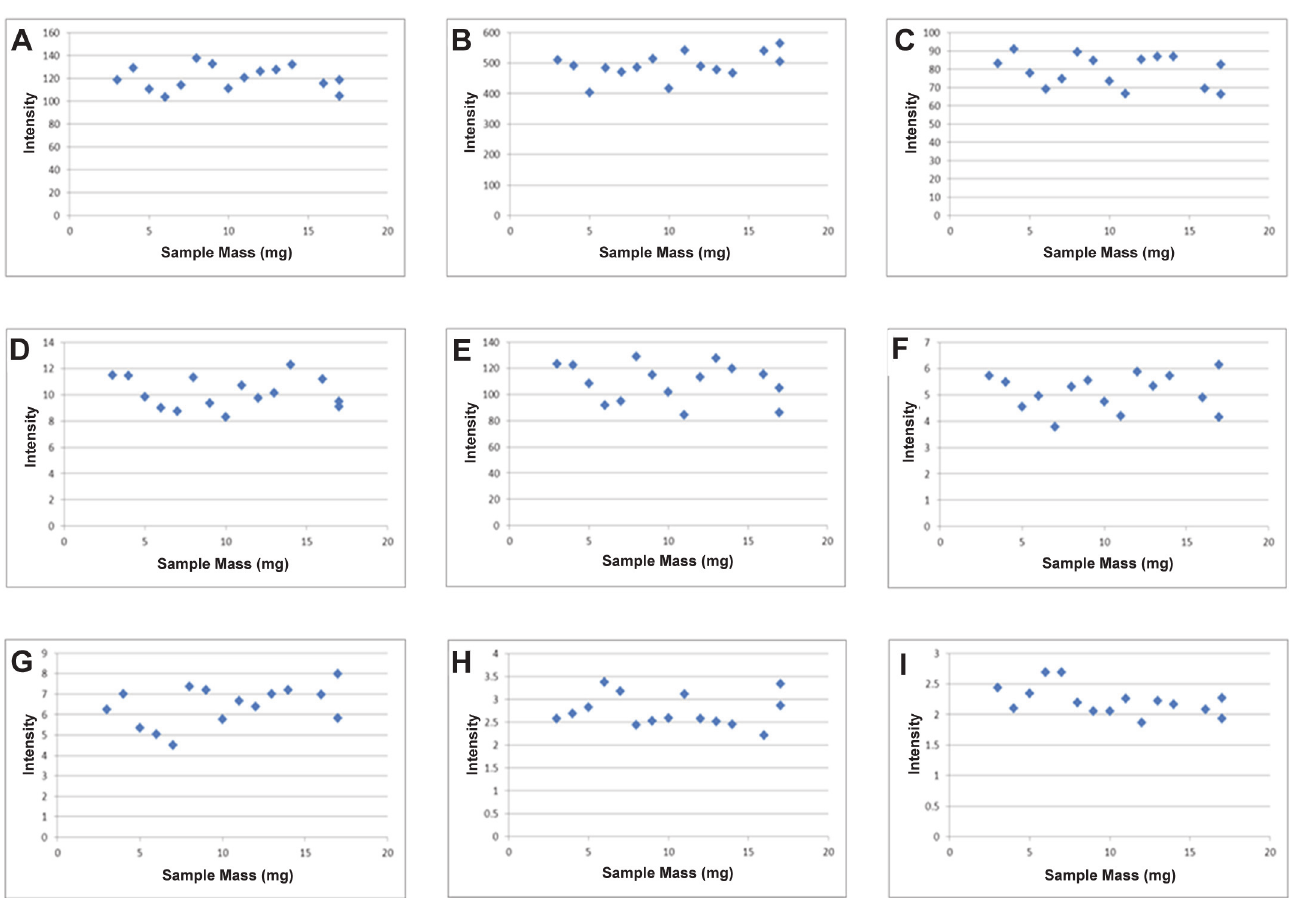
Fig 7. Plots of sample mass in milligrams against intensity for 9 annotated metabolites. A) taurine B) hypoxanthine C) glutamate D) pantothenate E) aspartate F) glcosylceramide (36:1) G) phosphatidylethanolamine (38:4) H) ceramide (38:1) I) triglyceride (48:3).